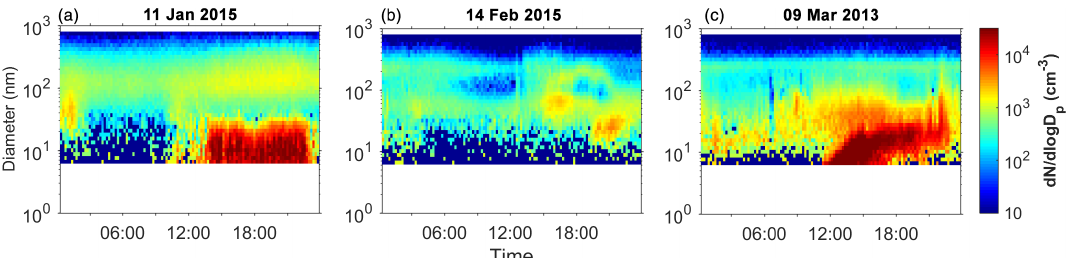
Figure 3. Examples of the time evolution of the aerosol size distribution in Puijo for (a) an undefined day characterized by a burst in the number concentrations of the small particles which does not have the characteristics of a typical NPF event day, (b) a typical undefined day, and (c) a clear NPF event